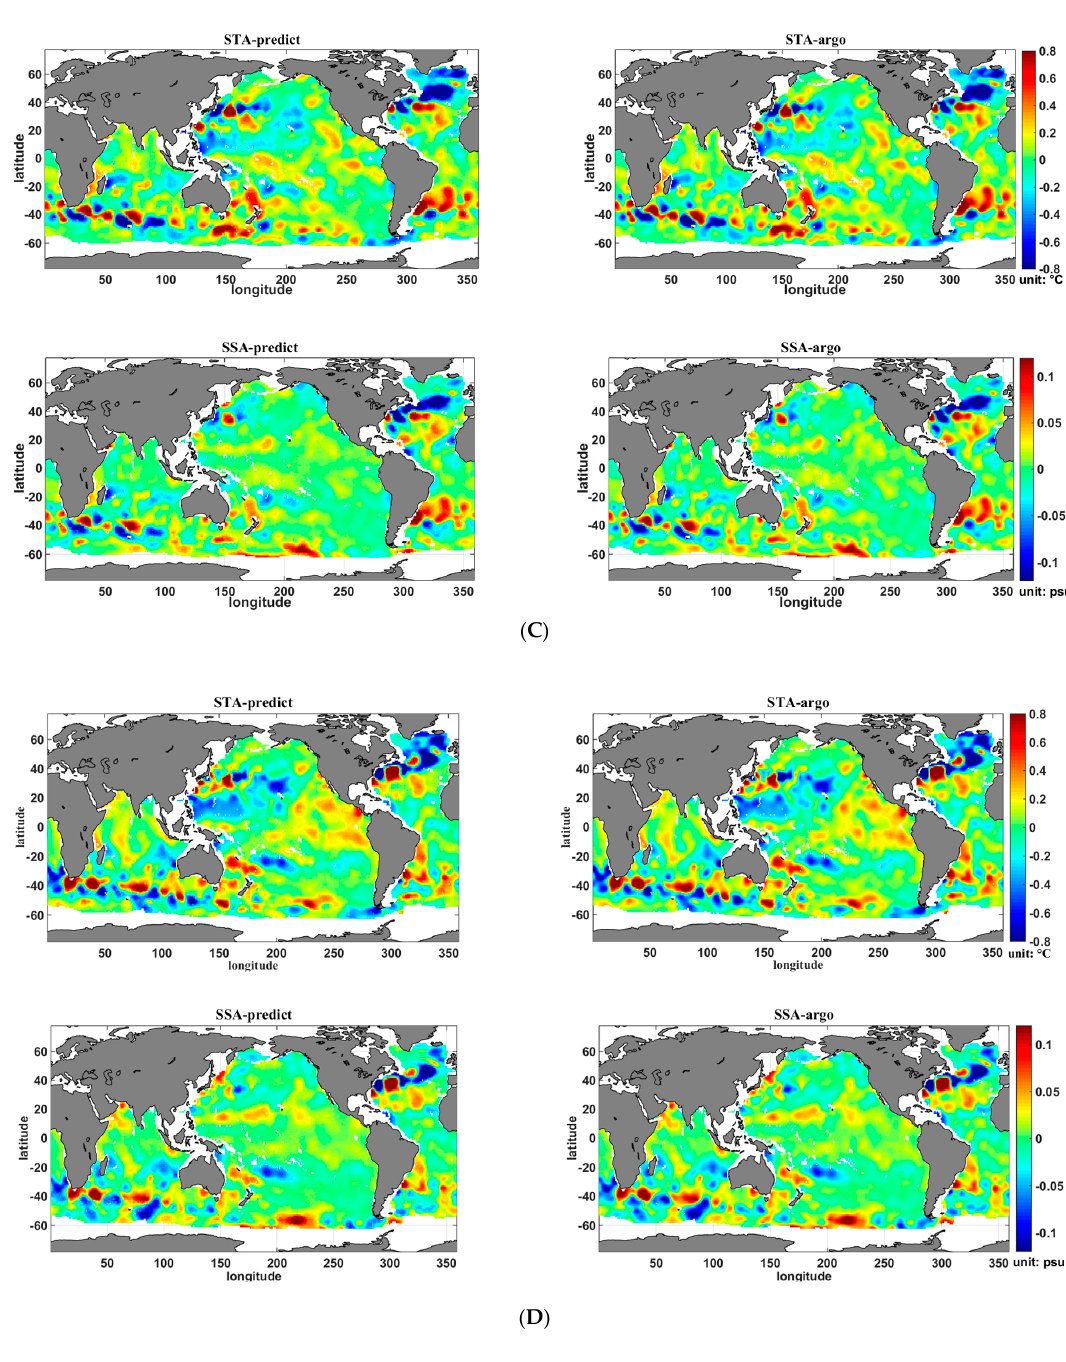
Figure 4. Spatial distribution of STA and SSA from the XGBoost-estimated results and the Argo data at 500 m for the different seasons in 2015: ( A ) January, ( B ) April, ( C ) July, and ( D ) October. At depths below 500 m (in the deeper ocean), the El Niño phenomenon became weaker and the negative anomaly in the western Pacific was much weaker or even diminished at 500 m, even though there remained a high anomaly in the eastern Pacific Ocean. For both the STA and SSA patterns, the signals in the Southern Ocean and Atlantic Ocean were more intense and significant than those in the central ocean basin, possibly due to the strong boundary current and mesoscale eddy processes in the deeper ocean such as the Antarctic Circumpolar Current (ACC), Gulf Stream, and Kuroshio Current. The STA and SSA signals had little seasonal variation but both showed a latitudinal alternation distribution over the Southern Ocean and the northern Atlantic Ocean. From depths of 1000 m